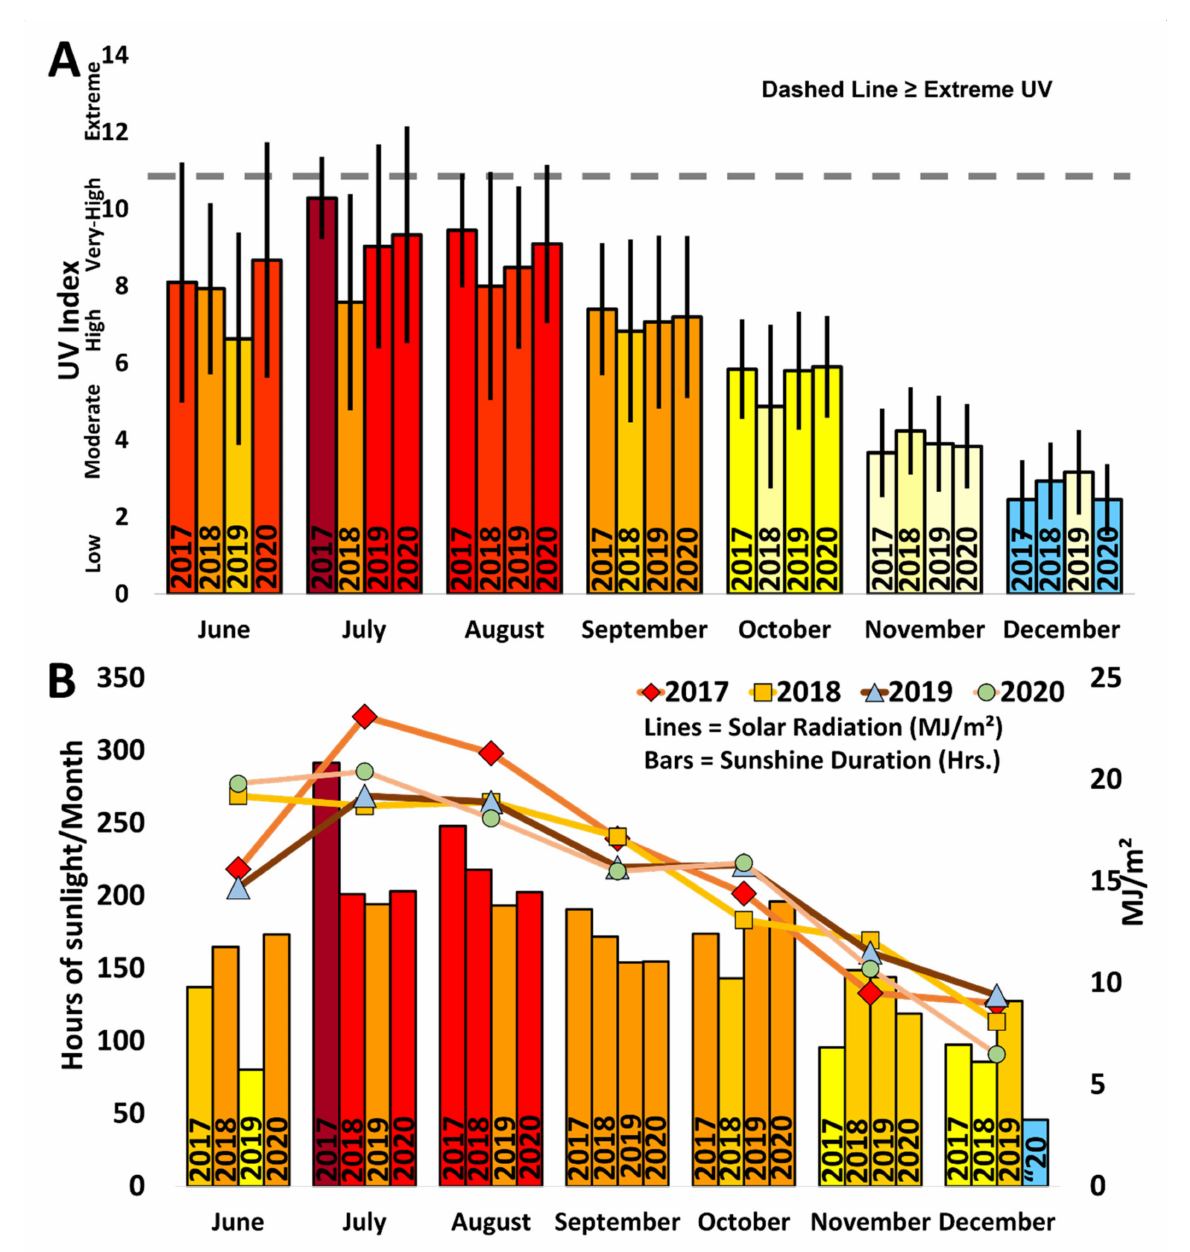
Figure 4. ( A ) UV index during the period of assessment (summer to early autumn), each bar represents the monthly mean of maximum UV index over the Nakijin/Motobu area for the month. Each bar represents year 2017–2020 under each month (left to right) (Central Western Okinawa). The left axis indicates the severity of UV radiation index. The colors in ( A ) represents the monthly UV index value and as per the Standard JMA color scale. The dashed line indicates the threshold for extreme UV radiation index; ( B ) Total sunshine duration and mean solar radiation. Each bar represents the total amount of hours of sunlight for every month (at Nago), and each marker represents the monthly mean global solar radiation (at Naha). The bars go from left to right under each month (2017 to 2020). The data and figures are adapted and modified from